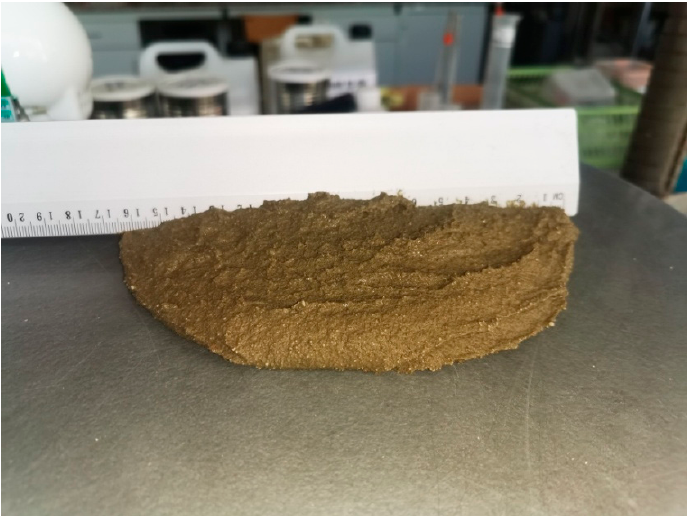
Figure 2. View of the C1 sample after flow test.